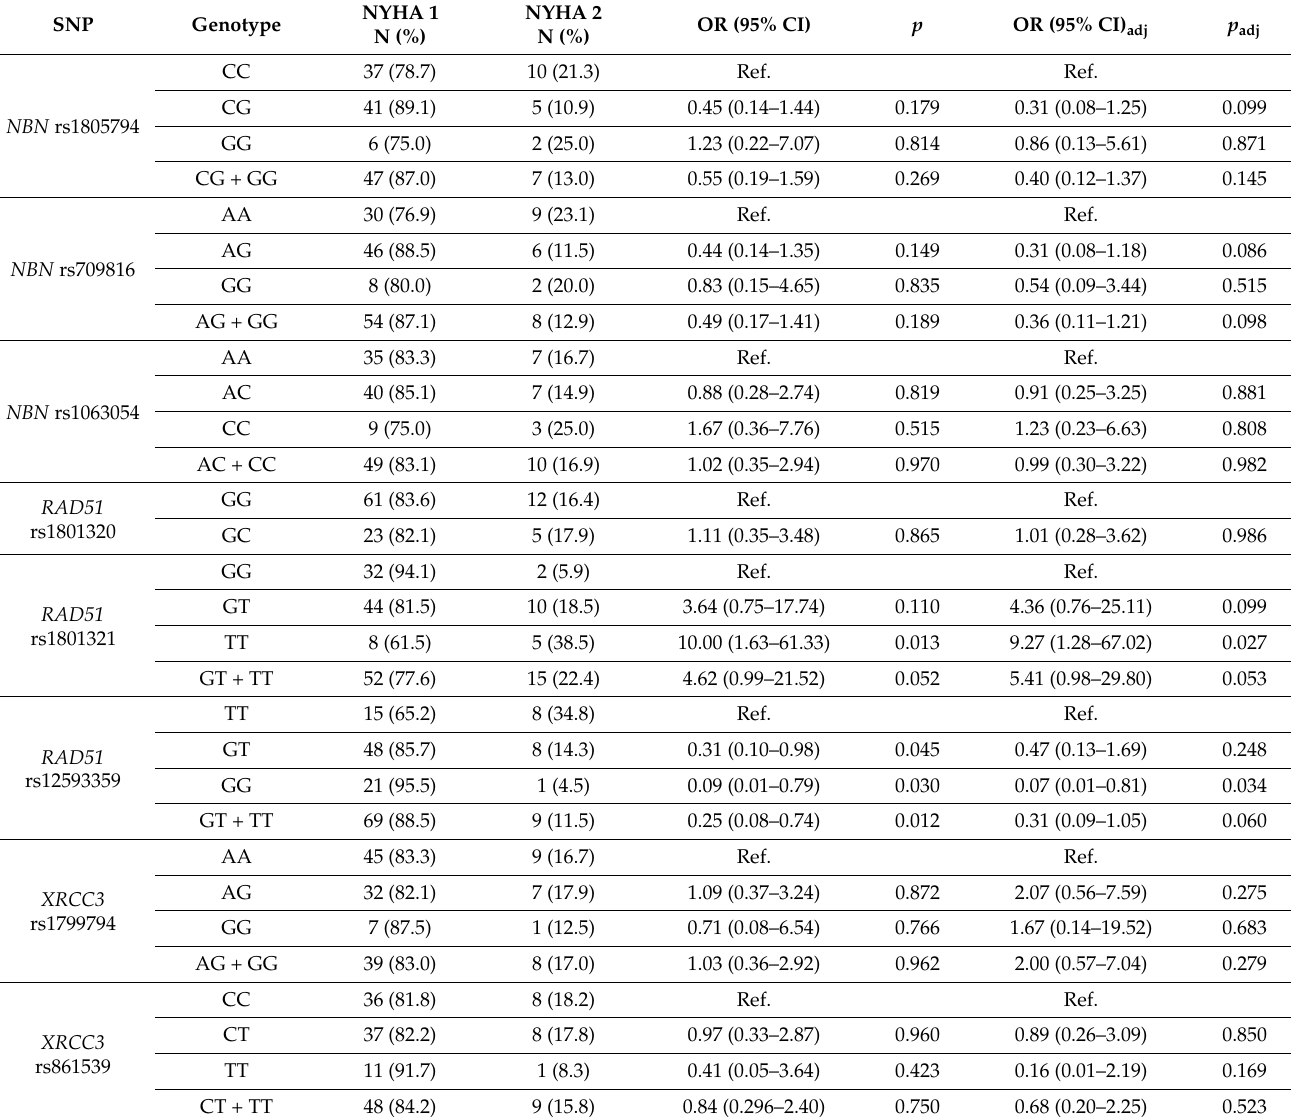
Table 6. Association of selected polymorphisms in HRR genes with NYHA